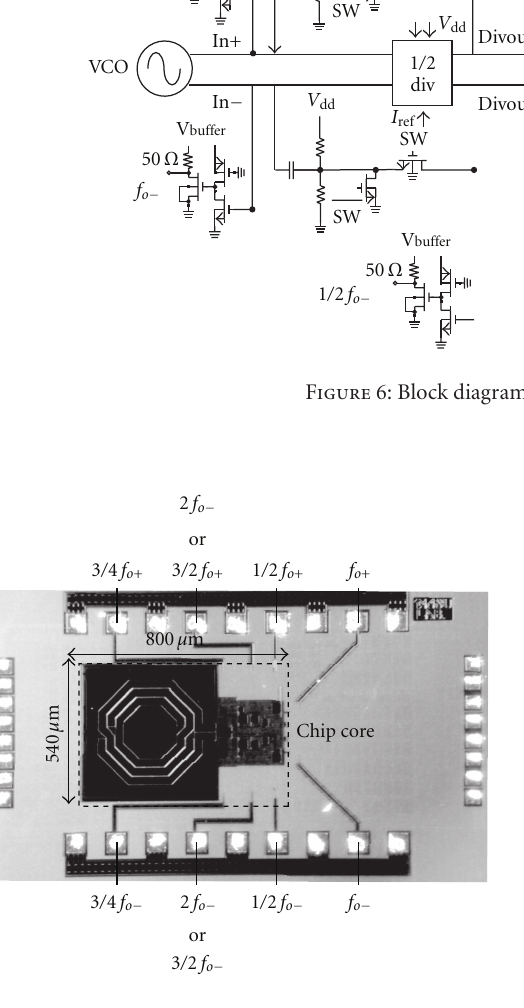
Figure 7: Chip micrograph of fabricated wideband VCO. Core size is 540 µ m × 800 µ m.